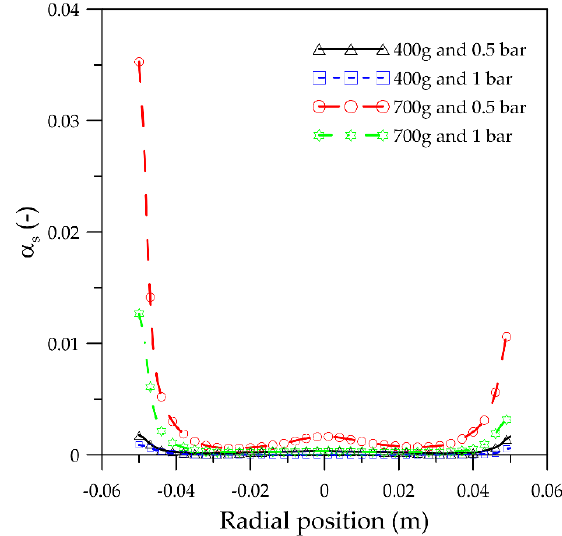
Figure 8. Radial distribution of the time-averaged solid volume fraction at a fixed axial position of 0.145 m from the equipment bottom (transport region).